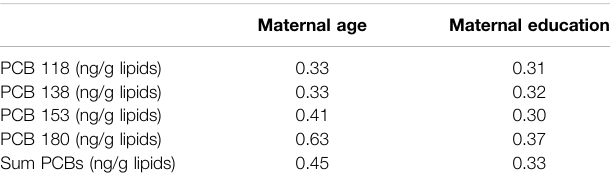
TABLE 2 | Spearman rank correlations of PCBs (lipid adj.) and maternal age and education in the EHF-Assaf-Harofeh-Ichilov birth cohort, Israel, 2013 – 2015 ( n = 150).